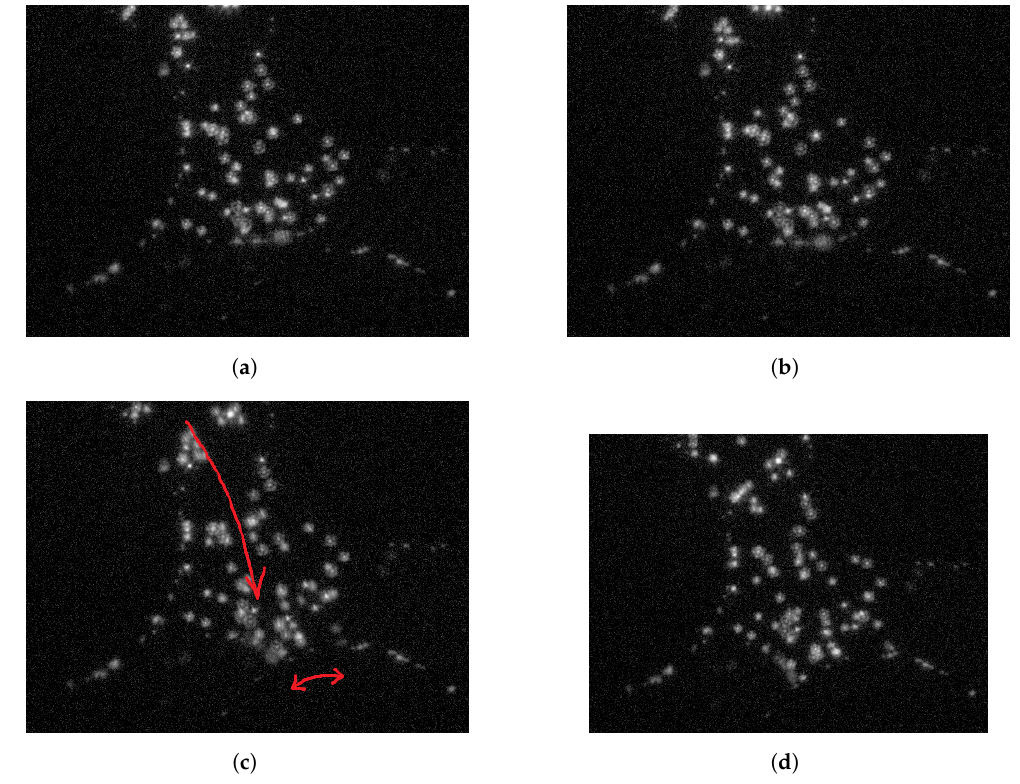
Figure 9. Cropped view of Haines Jump occurring as branch 17 splits into branches 18 and 19. The long unidirectional arrow indicates the direction of flow, and the shorter bidirectional arrow indicates the split. ( a ) Frame 2448 in the 150mbar experiment; ( b ) Frame 2453 in the 150mbar experiment; ( c ) Frame 2458 in the 150mbar experiment; and ( d ) Frame 2463 in the 150mbar